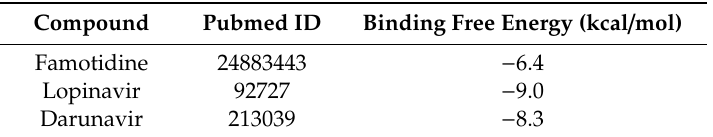
Table 2. Binding free energies calculated for famotidine and other protease inhibitors upon docking to the SARS-CoV2 main